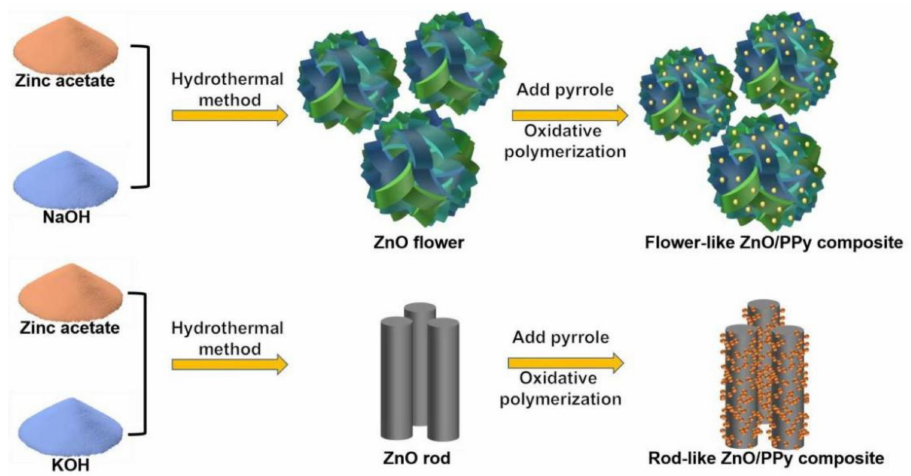
Figure 1. Schematic illustration of flower-like ZnO/PPy and rod-like ZnO/PPy